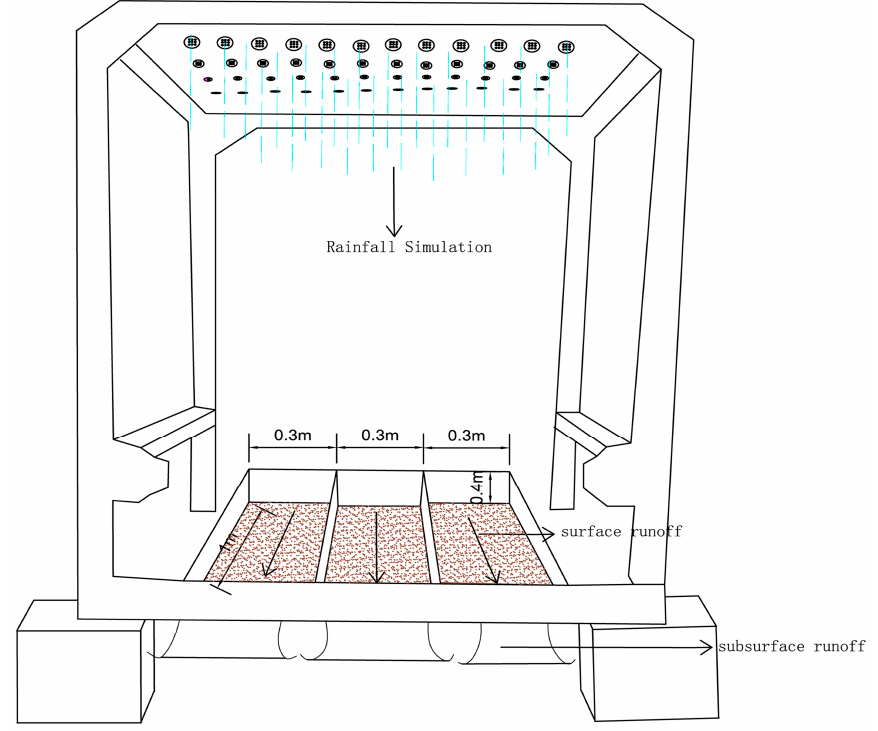
Figure 1. Rainfall simulator and runoff trays placement.